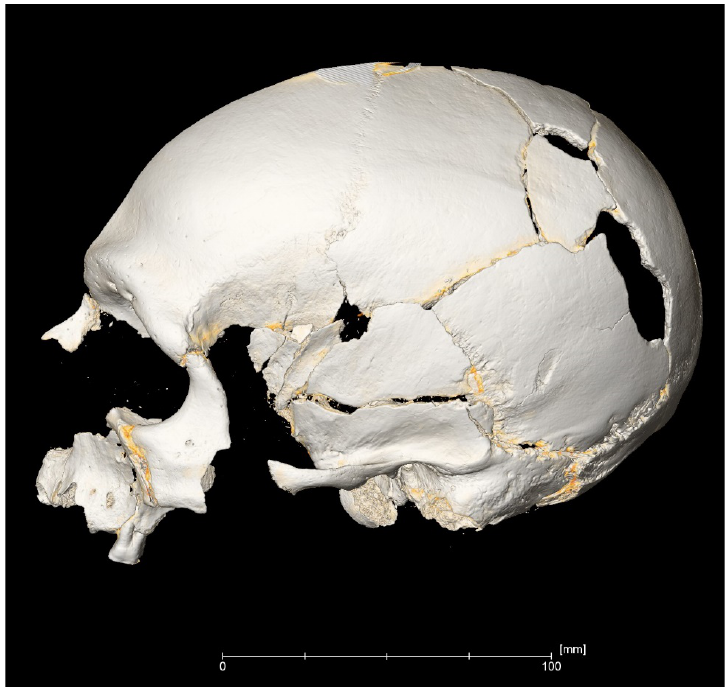
Figure 4. Virtual 3D reconstruction of a male skull from the Pepkino mound with damage from battle axes. The yellow layers are virtual tracks of the beeswax material. We identified solid and multiple oval-shaped wounds caused by battle axes. The majority of them, represented by holes surrounded by radiating fractures, were associated with a high-velocity hit by a heavy weapon and could not indicate the type of battle axe directly. However, a superficial oval defect in the lower part of the left parietal bone was visible after X-ray microtomography reconstruction (Figure 5).